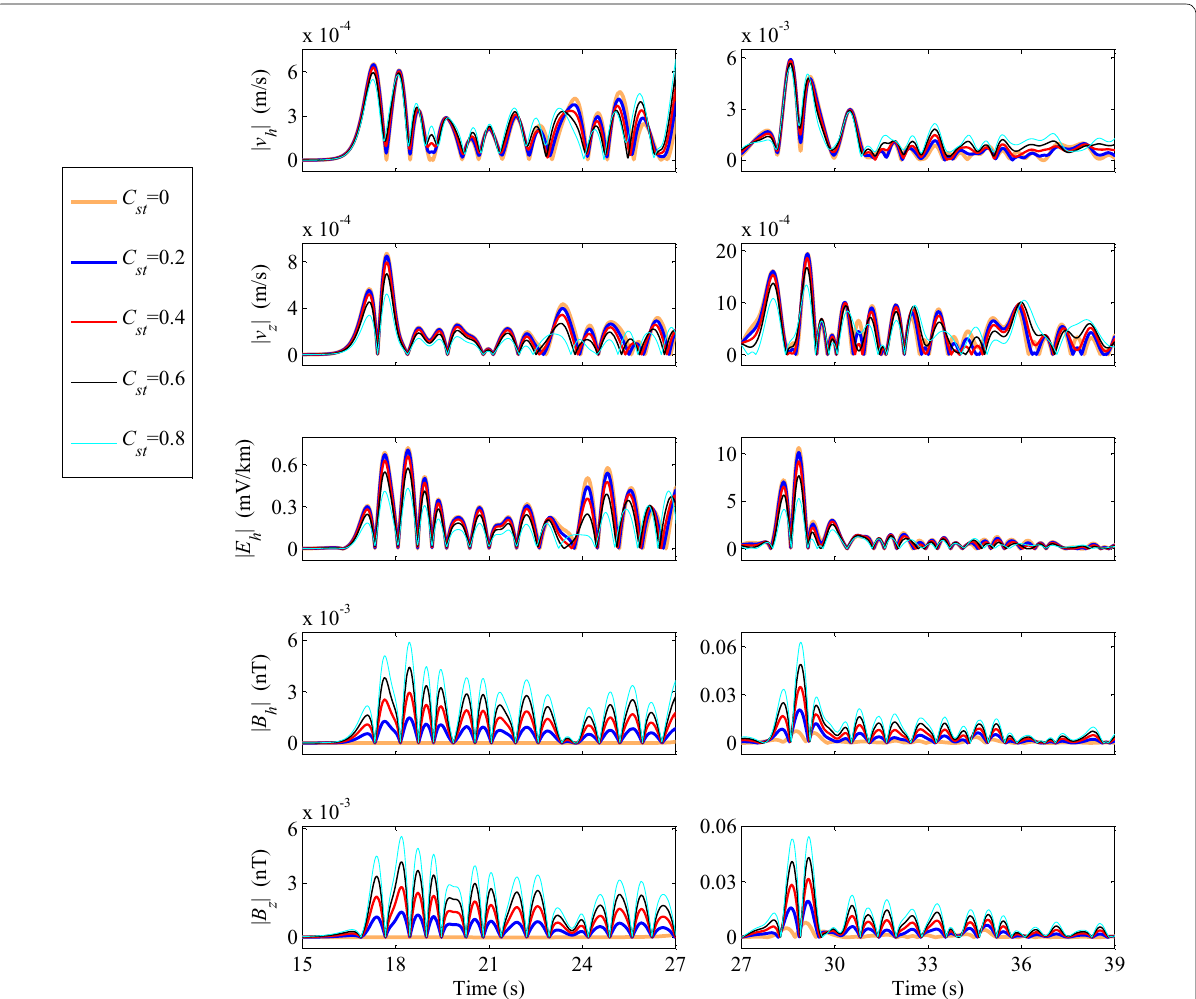
Fig. 11 Influence of scattering effect on the amplitudes of seismic and EM wave‑fields. We calculate the absolute amplitudes of horizontal total components and vertical components of the seismic and EM wave‑fields simulated for the receiver located at ( seven‑layer half‑space model when different artificial scattering conversion coefficients C st